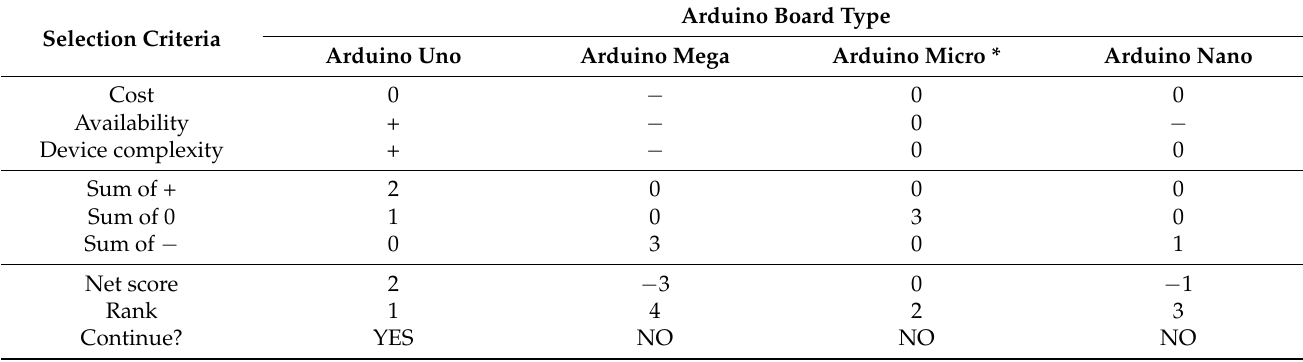
Table 8. Screening of Arduino board types.